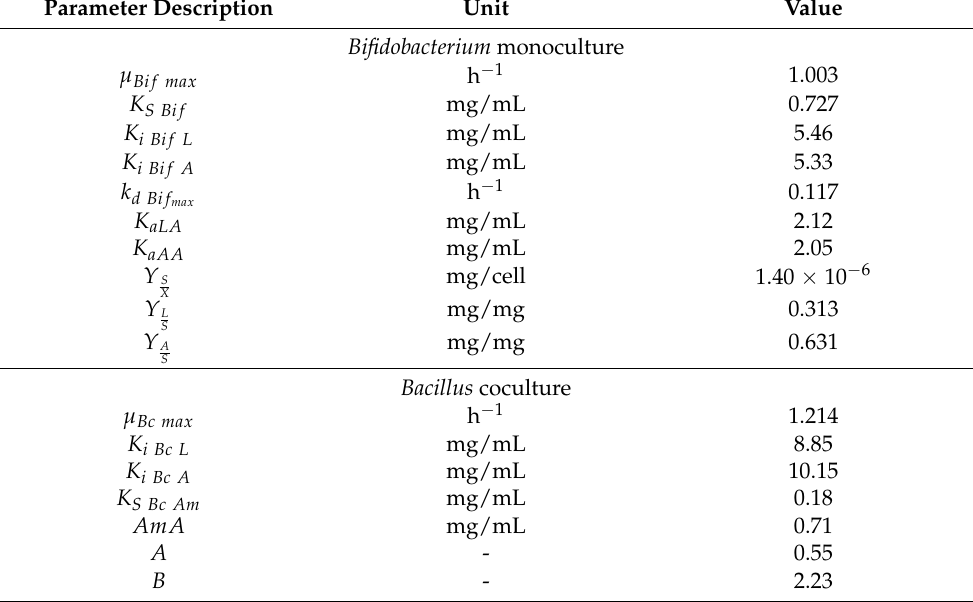
Table 1. The model parameter values.